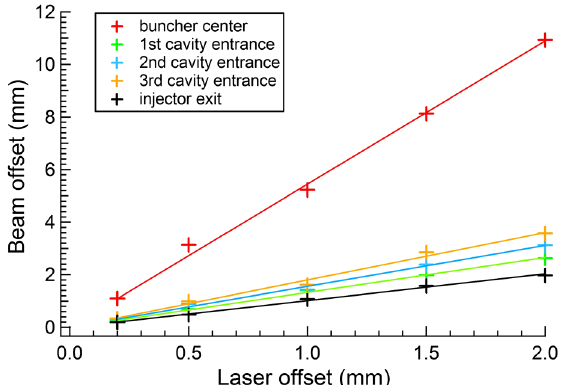
FIG. 8. The beam offset required in each cavity to compensate for the emittance growth due to off-axis beam emission is shown for different values of the initial laser offset (crosses). The values of the optimal beam offset at the injector exit are shown as black crosses. The colored lines denote linear fits to the data.